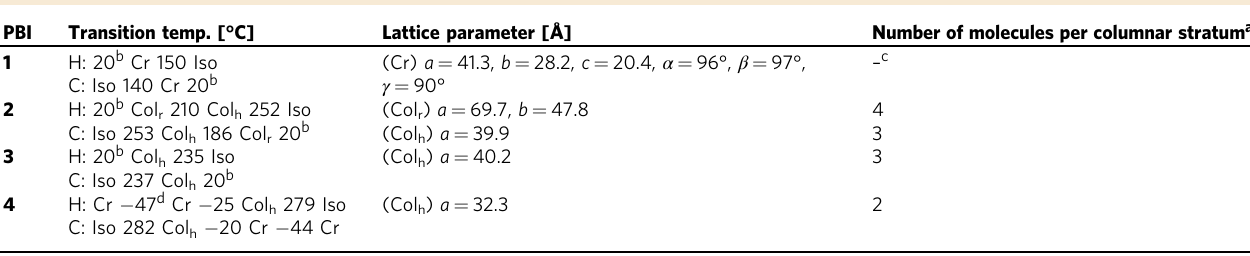
Table 1 LC behavior and lattice parameter of PBIs 1 – 4 PBI Transition temp. [°C] Lattice parameter [Å]